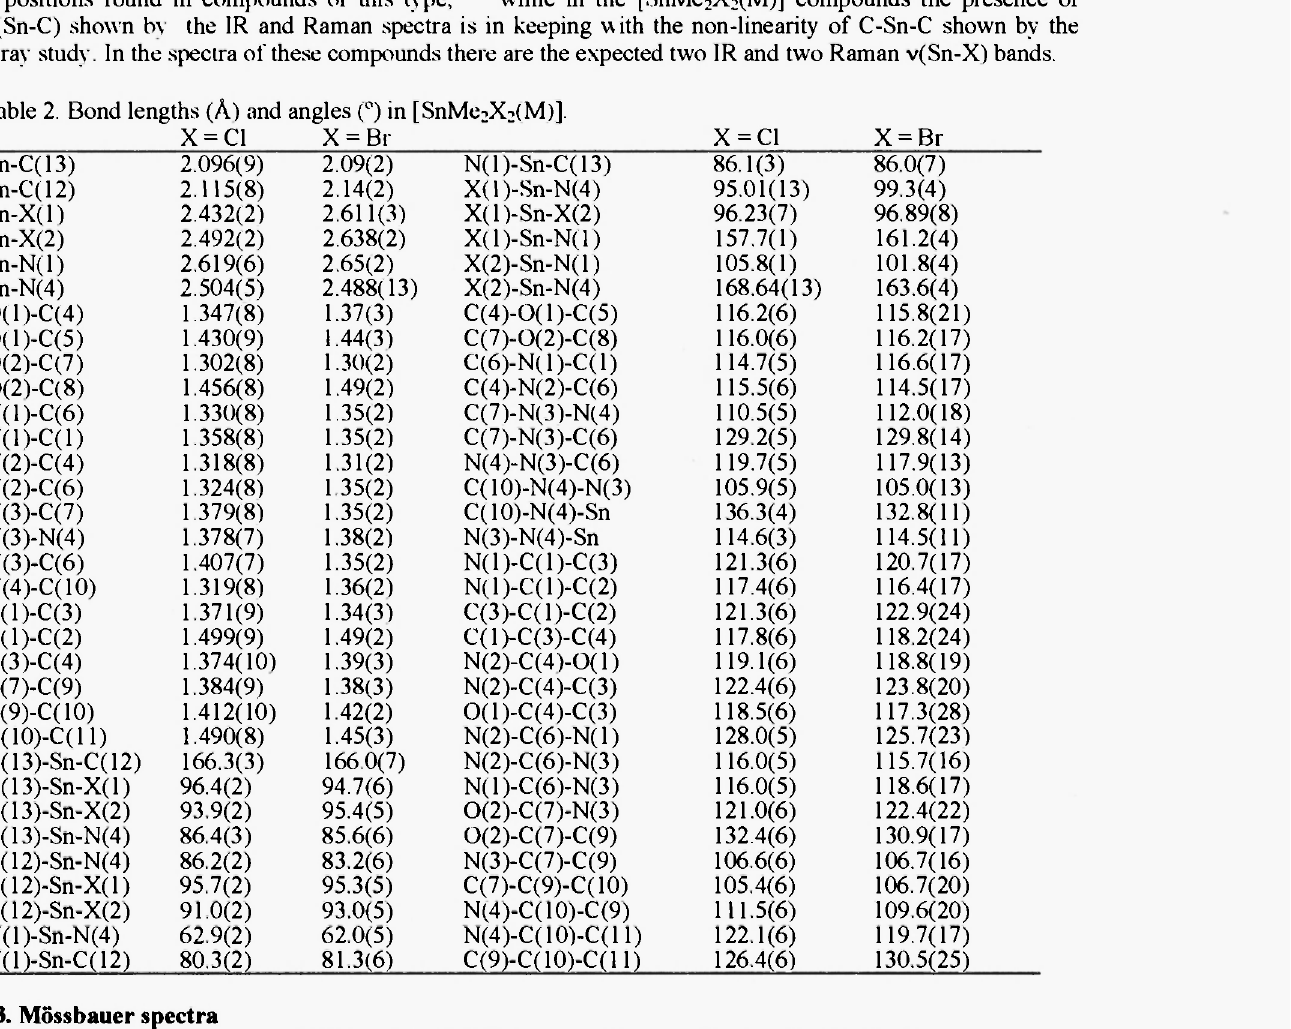
Table 2. Bond lengths (A) and angles (°) in [SnMc : X :